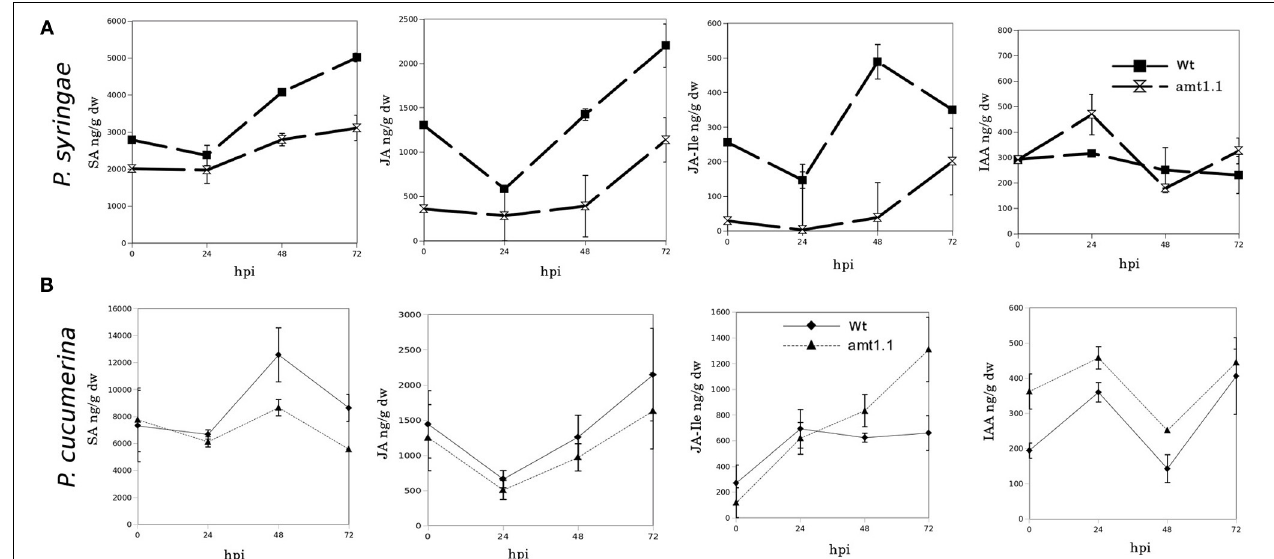
FIGURE 4 | SA, JA, JA-Ile, and IAA profiling upon P. syringae and P. cucumerina infection. Plants were challenged as described in Figure 1 . Both mock and pathogen infected plants were harvested at different time-points. Freeze dried material was processed for a targeted quantification analysis by TQD-MS.Theconcentrationofthehormoneswasdeterminedinallthesamples